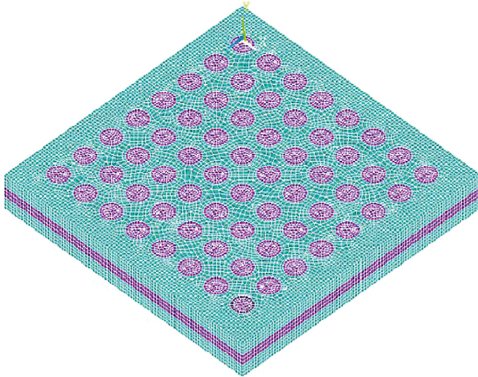
Figure 24: Finite element